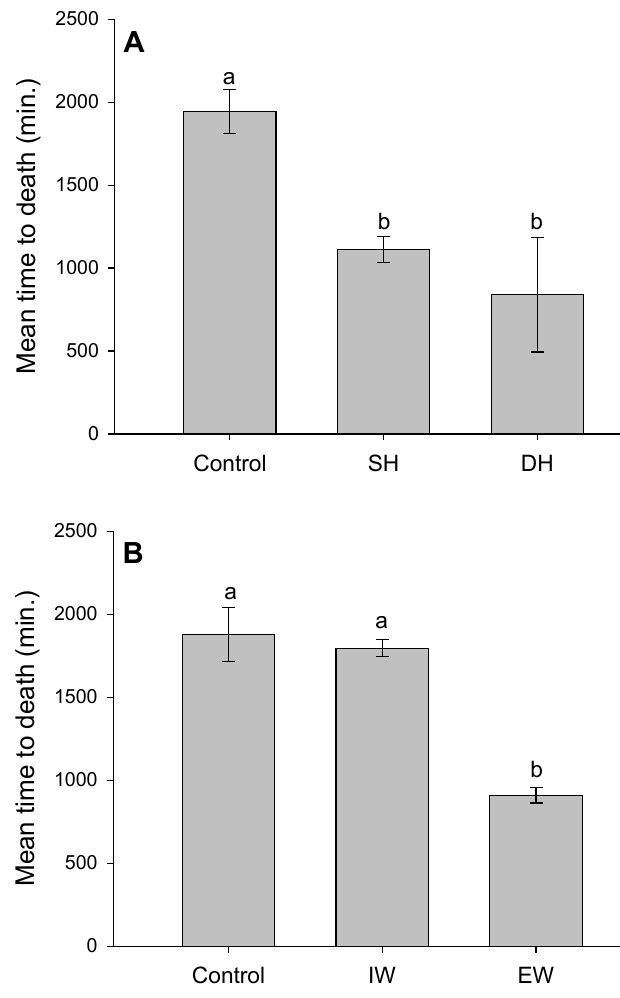
Fig 1. Survival of Inquilinitermes microcerus workers in different treatments. A) Control (inquilines workers alone), SH (inquiline workers with host workers from the same nest), DH (inquiline workers with host workers from different nest; B) control (inquiline workers alone), IW (inquiline workers in contact with inner wall of host nest), EW (inquiline workers in contact with external wall of host nest). Different letters in each graphic indicates significant difference among